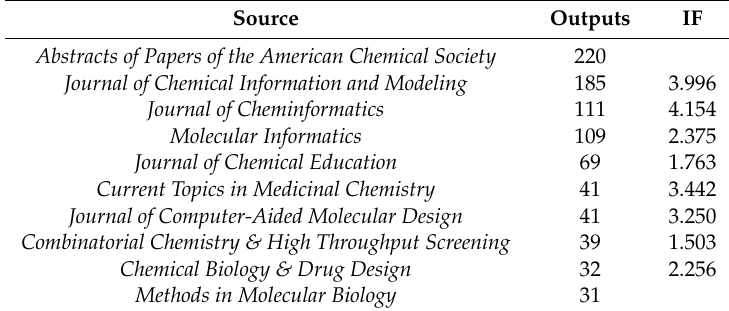
Table 1. Sources producing the largest numbers of chemoinformatics outputs. Source Outputs IF Abstracts of Papers of the American Chemical